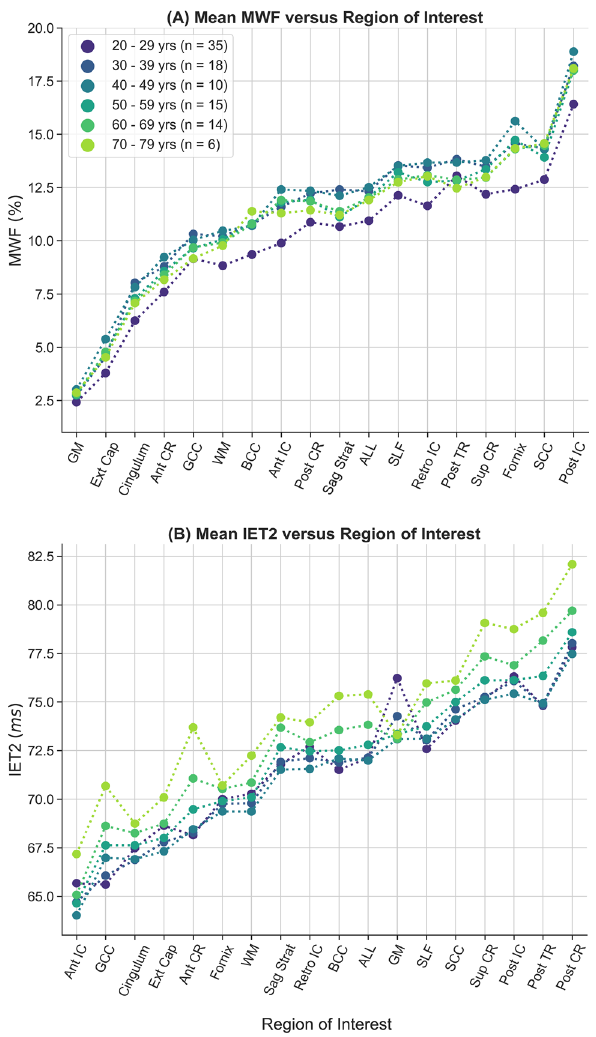
Figure 4. Rank of average A) myelin water fraction (MWF) and B) geometric mean T 2 of intra- and extra- cellular water (IET2) for subjects grouped by decade of age within gray/white matter (GM/WM), external capsules (Ext Cap), cingulum, anterior/posterior/superior corona radiata (Ant/Post/Sup CR), anterior/posterior/ retrolenticular internal capsule (Ant/Post/Retro IC), sagittal stratum (Sag Strat), all JHU labels (ALL), superior longitudinal fasciculus (SLF), posterior thalamic radiation (Post TR), fornix (Fornix), and genu/body/splenium of corpus callosum (G/B/S